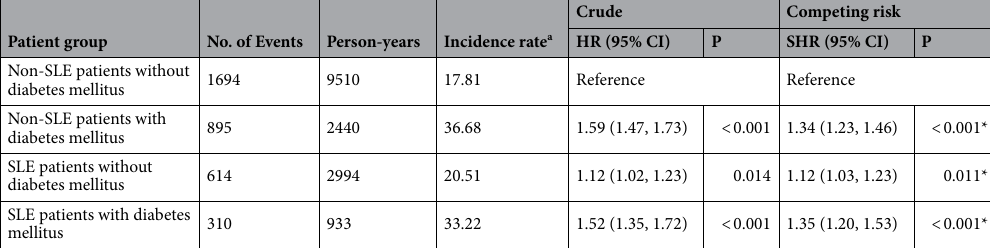
Table 4. Incidence rates and risks of AVF/AVG dysfunction in SLE and non-SLE patients with and without diabetes mellitus. AVF arteriovenous fistula, AVG arteriovenous graft, SLE systemic lupus erythematosus, HR hazard ratio, SHR subdistribution hazard ratio, CI confidence interval. a Per 100 person-years.